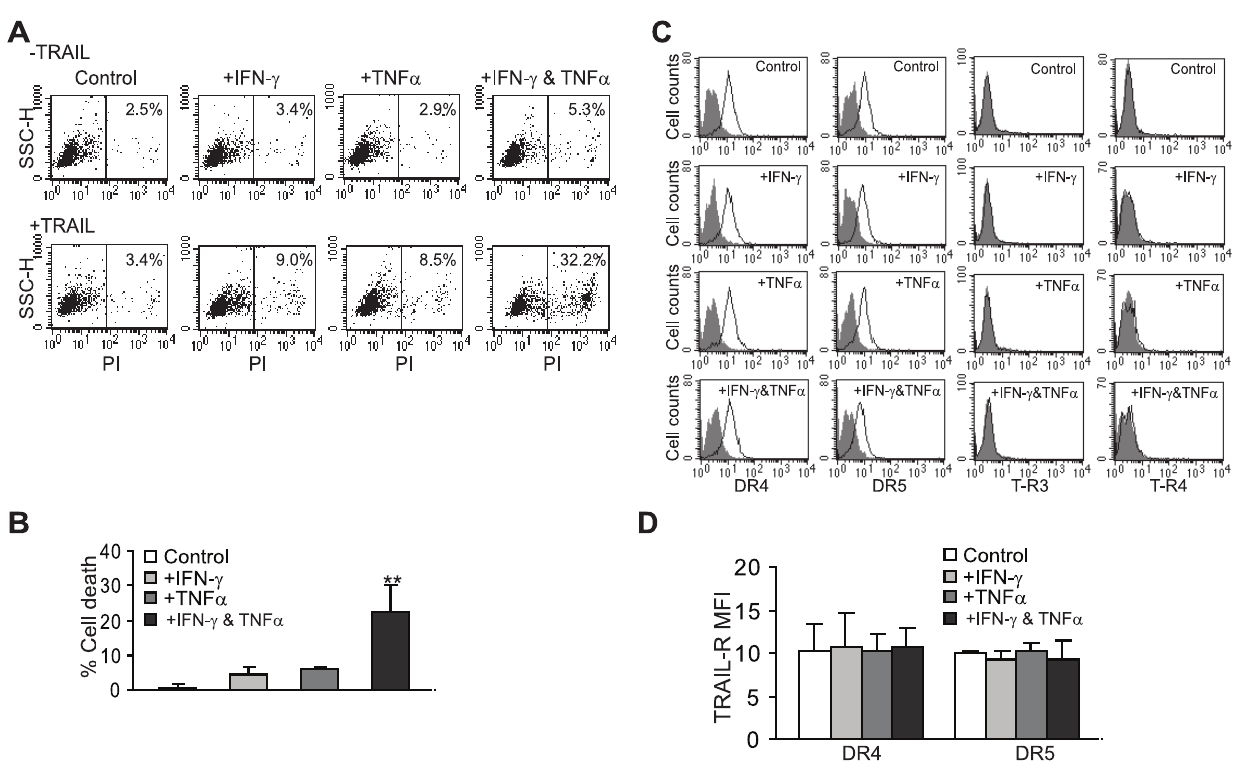
Figure 1. TNF a cooperates with IFN- c to sensitize human colon carcinoma cells to TRAIL-induced apoptosis. A . TRAIL-induced apoptosis. TRAIL-resistant SW620 cells were either untreated (control), treated with IFN- c (100 U/ml), TNF a (100 U/ml), or both IFN- c and TNF a overnight, followed by incubation with recombinant TRAIL (100 ng/ml). Cell death was analyzed by PI staining and flow cytometry analysis. B . Percent TRAIL-induced cell death was calculated as % PI-positive cells in the presence of TRAIL ( + TRAIL) - % PI positive in the absence of TRAIL (-TRAIL). Column : mean, bar : SD. C&D . Expression level of cell surface TRAIL receptors. SW620 cells were treated with IFN- c , TNF a , or both IFN- c and TNF a for approximately 24 h and stained with the receptor-specific antibodies, respectively. The stained cells were then analyzed with flow cytometry. Isotype-matched IgG control staining is depicted as gray areas, and DR4-, DR5-, T-R3- and T-R4-specific staining is depicted as solid lines. The mean fluorescent intensity (MFI) of DR4 and DR5 are quantified (D). Column : mean, bar : SD.